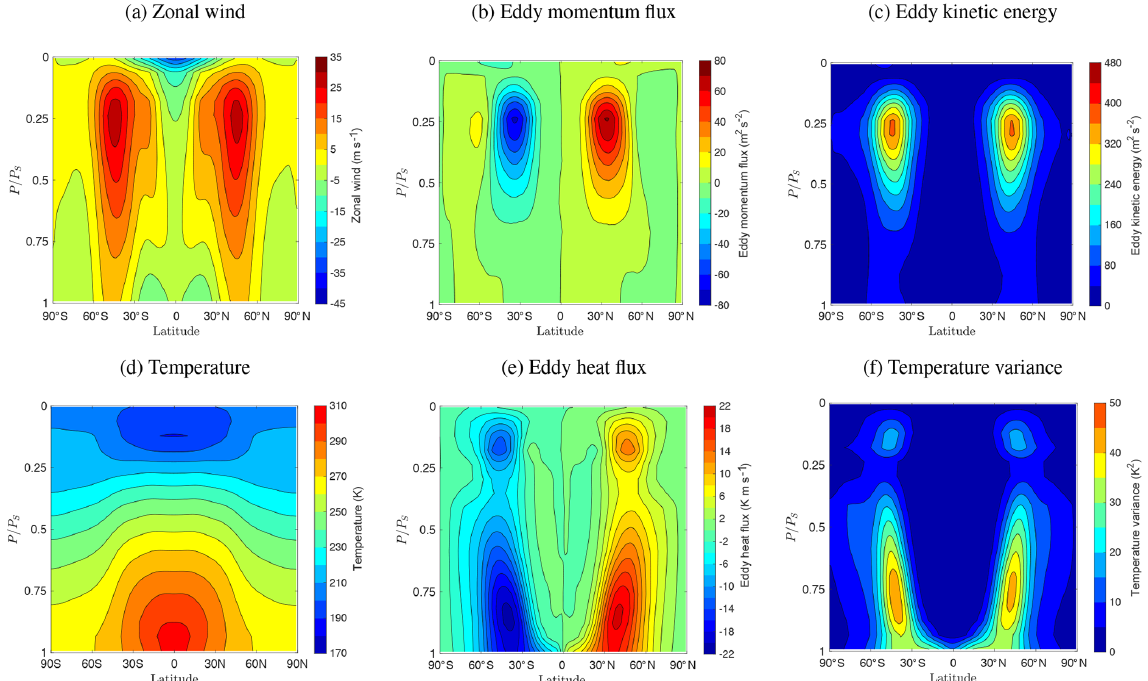
Figure 13. Time–zonal statistics for the low-resolution (Held and Suarez, 1994) test case with scales J = 4 , 5 , 6 (maximum resolution of 1 ◦ ). The grid is adapted on the solution error with tolerance ε = 0 . 04. Statistics are averaged over 400 days after day 200 by interpolating saved data to the finest grid.